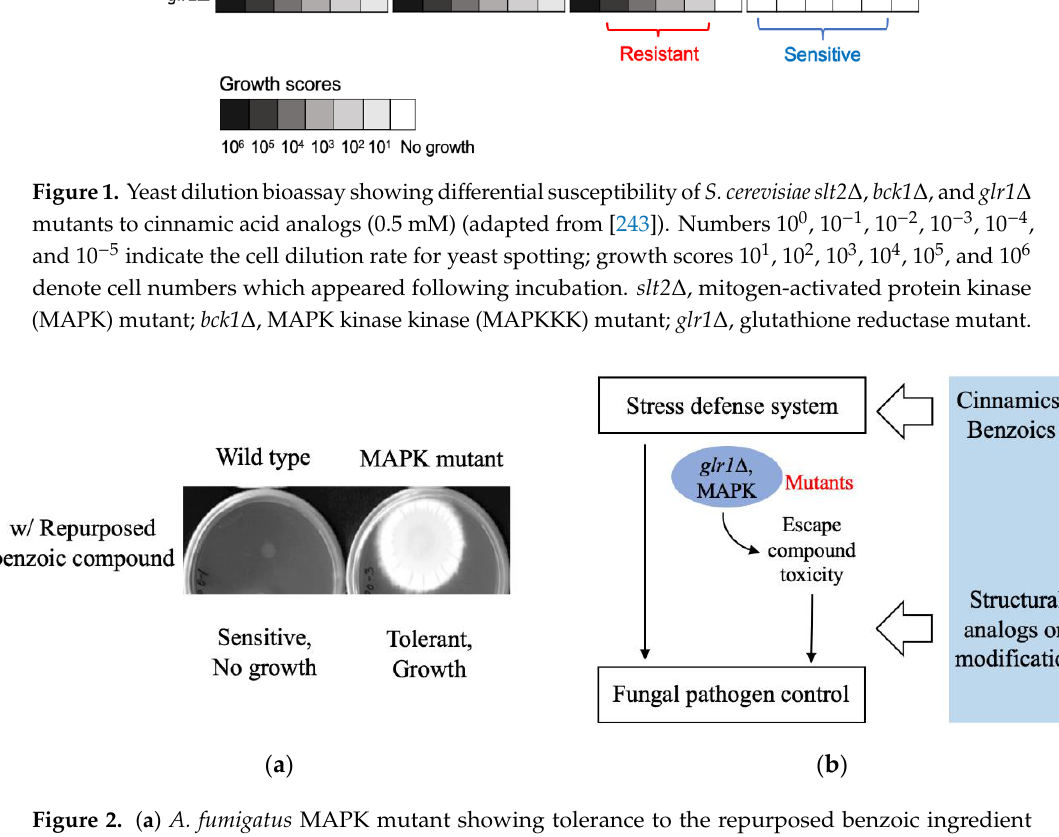
Figure 1. Yeast dilution bioassay showing differential susceptibility of S. cerevisiae slt2 Δ, bck1 Δ, and glr1 Δ mutants to cinnamic acid analogs (0.5 mM) (adapted from [243]). Numbers 10 0 , 10 −1 , 10 −2 , 10 −3 , 10 −4 , and 10 −5 indicate the cell dilution rate for yeast spotting; growth scores 10 1 , 10 2 , 10 3 , 10 4 , 10 5 , and 10 6 denote cell numbers which appeared following incubation. slt2 Δ, mitogen-activated protein kinase (MAPK) mutant; bck1 Δ, MAPK kinase kinase (MAPKKK) mutant; glr1 Δ, glutathione reductase mutant.